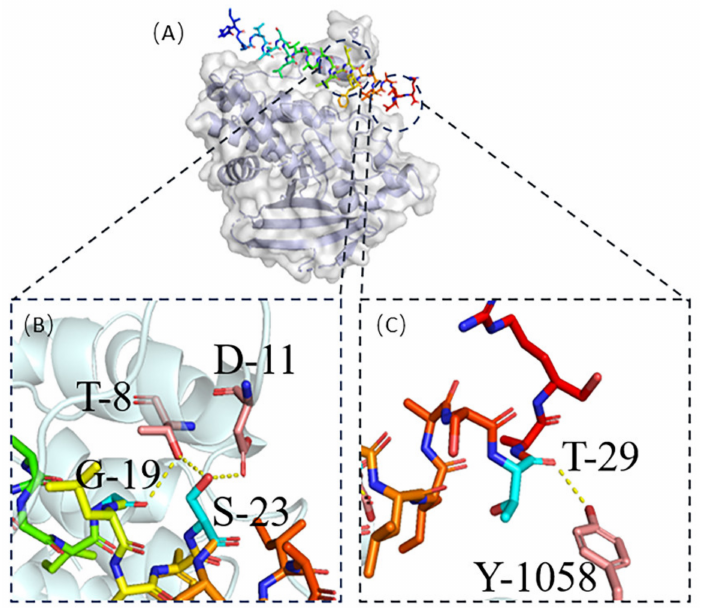
Figure 4. ( A ) Protein No. 2- PTPRJ complex; ( B ) The active residues around Protein No. 2 binding to PTPRJ ( C ) The active residues around Protein No. 2 binding to PTPRJ.